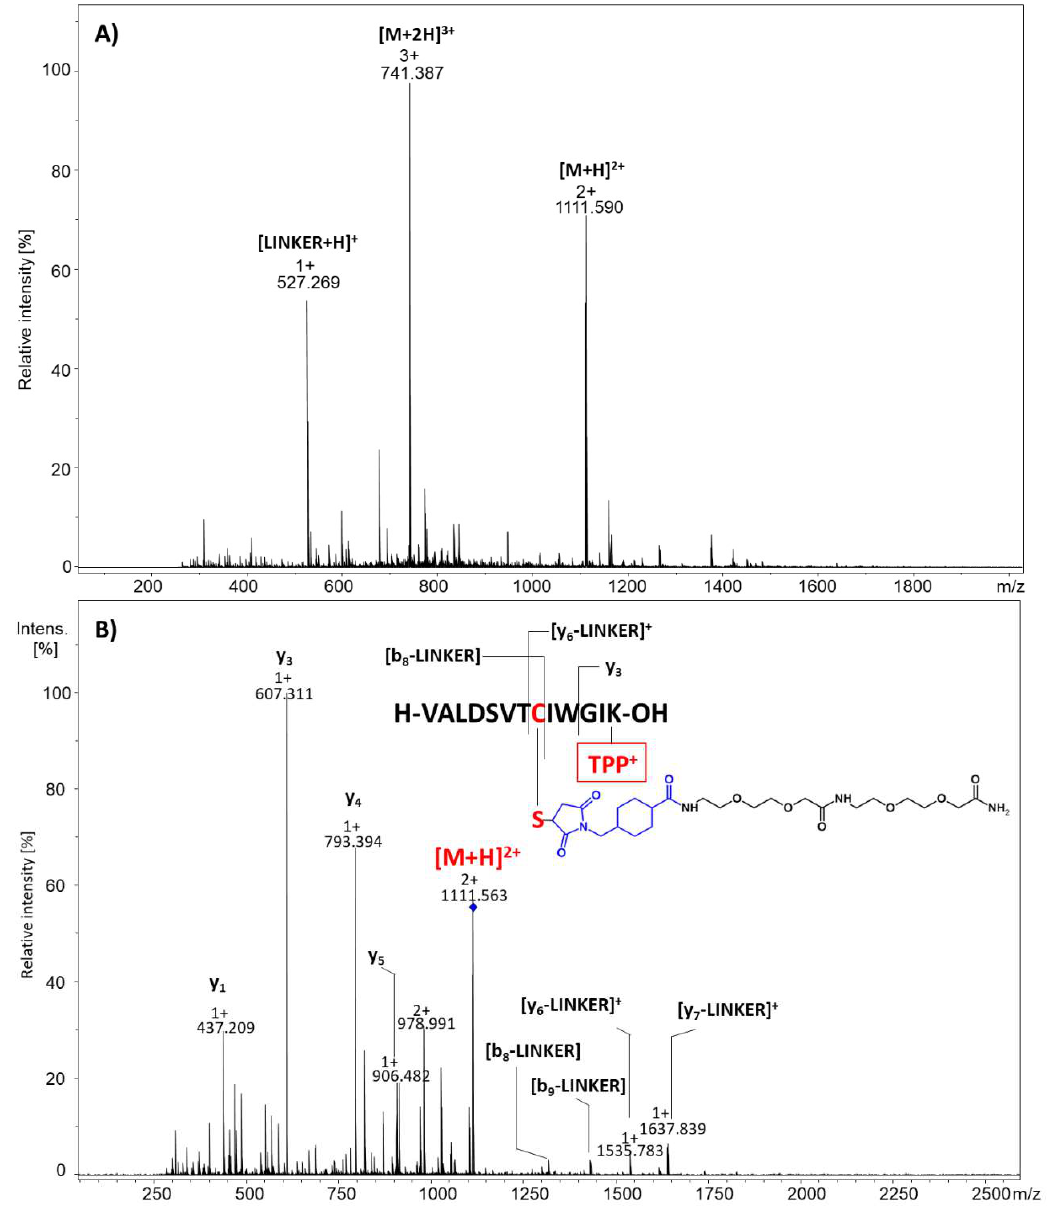
Figure3. ( A )ESI-MSspectrumoftheobtainedpeptideconjugatemodifiedbythequaternaryammonium Figure 3. ( A ) ESI-MS spectrum of the obtained peptide conjugate modified by the quaternary group in the form of the 2,4,6-triphenylpyridinium salt (TPP). ( B ) ESI-MS / MS spectrum of the obtained ammonium group in the form of the 2,4,6-triphenylpyridinium salt (TPP). ( B ) ESI-MS/MS spectrum peptide conjugate modified by TPP. Parent ion m / z 1111.074, collision energy 40 of the obtained peptide conjugate modified by TPP. Parent ion m/z 1111.074, collision energy 40 eV.